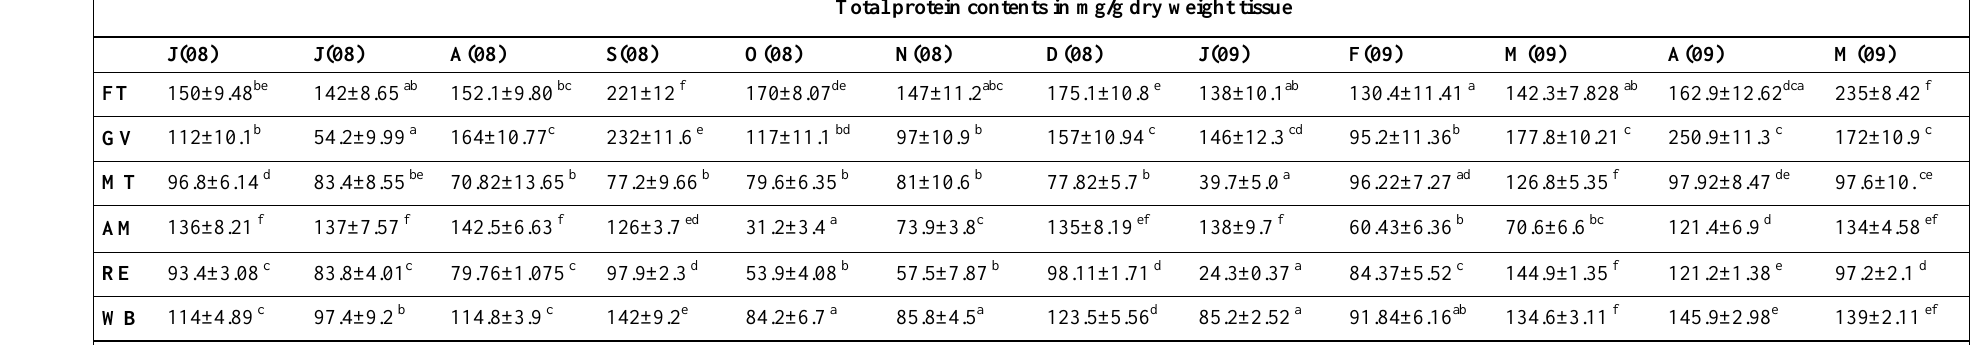
Table 2. Seasonal variations in the contents of total protein, glycogen and lipids (mg/g DW) of the body parts and whole body of clam Mactra stultorum. Total protein contents in mg/g dry weight